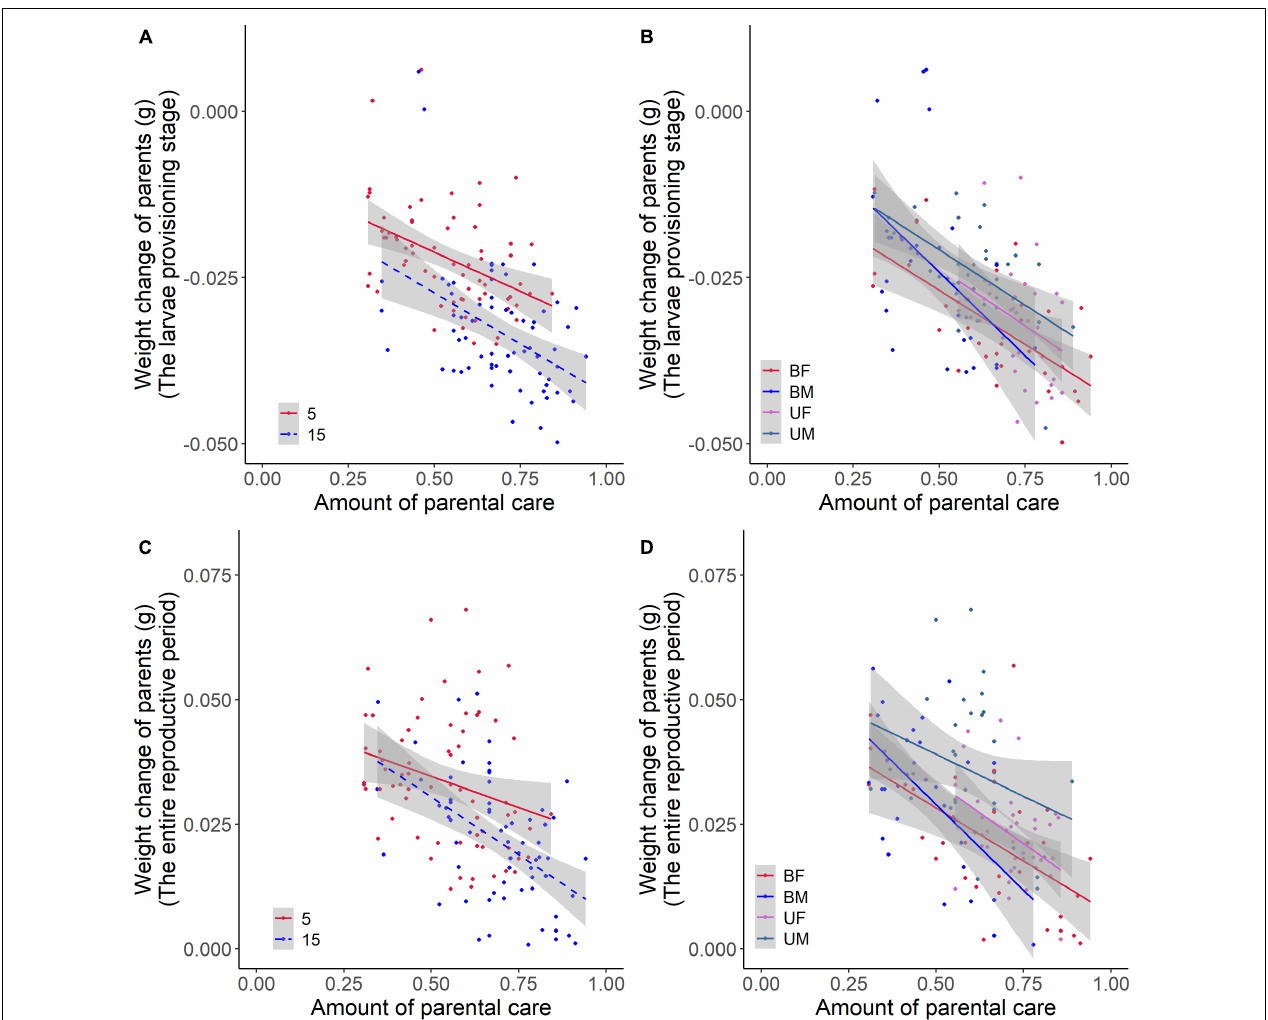
FIGURE 3 | Effects of the amount of parental care on weight change of burying beetle parents during the larvae provisioning stage and the entire reproductive period in the first breeding. The colored regression lines represent the relationship for each treatment ( ± 95% confidence intervals). The larvae provisioning stage (values below 0 indicate weight loss) for (A) brood size manipulations (Brood 5, y = –0.024x – 0.010, R 2 = 0.173, N = 67, P = 0.001; Brood 15, y = –0.031x – 0.012, R 2 = 0.200, N = 66, P < 0.001) and (B) parental care system treatments (UM, uniparental male, y = –0.033x – 0.004, R 2 = 0.329, N = 34, P < 0.001; UF, uniparental female, y = –0.035x – 0.006, R 2 = 0.112, N = 37, P = 0.0243; BM, biparental male, y = –0.050x – 0.001, R 2 = 0.201, N = 31, P = 0.007; BF, biparental female, y = –0.033x – 0.011, R 2 = 0.425, N = 31, P < 0.001). The entire reproductive period (values above 0 indicate weight gain) for (C) brood size manipulations (Brood 5, y = –0.025x + 0.047, R 2 = 0.061, N = 67, P = 0.025; Brood 15, y = –0.046x + 0.054, R 2 = 0.254, N = 66, P < 0.001) and (D) parental care system treatments (UM, uniparental male, y = –0.034x + 0.056, R 2 = 0.070, N = 34, P = 0.071; UF, uniparental female, y = –0.049x + 0.058, R 2 = 0.159, N = 37, P = 0.008; BM, biparental male, y = –0.069x + 0.063, R 2 = 0.319, N = 31, P = 0.001; BF, biparental female, y = –0.043x + 0.049, R 2 = 0.300, N = 31; P = 0.001) in the first